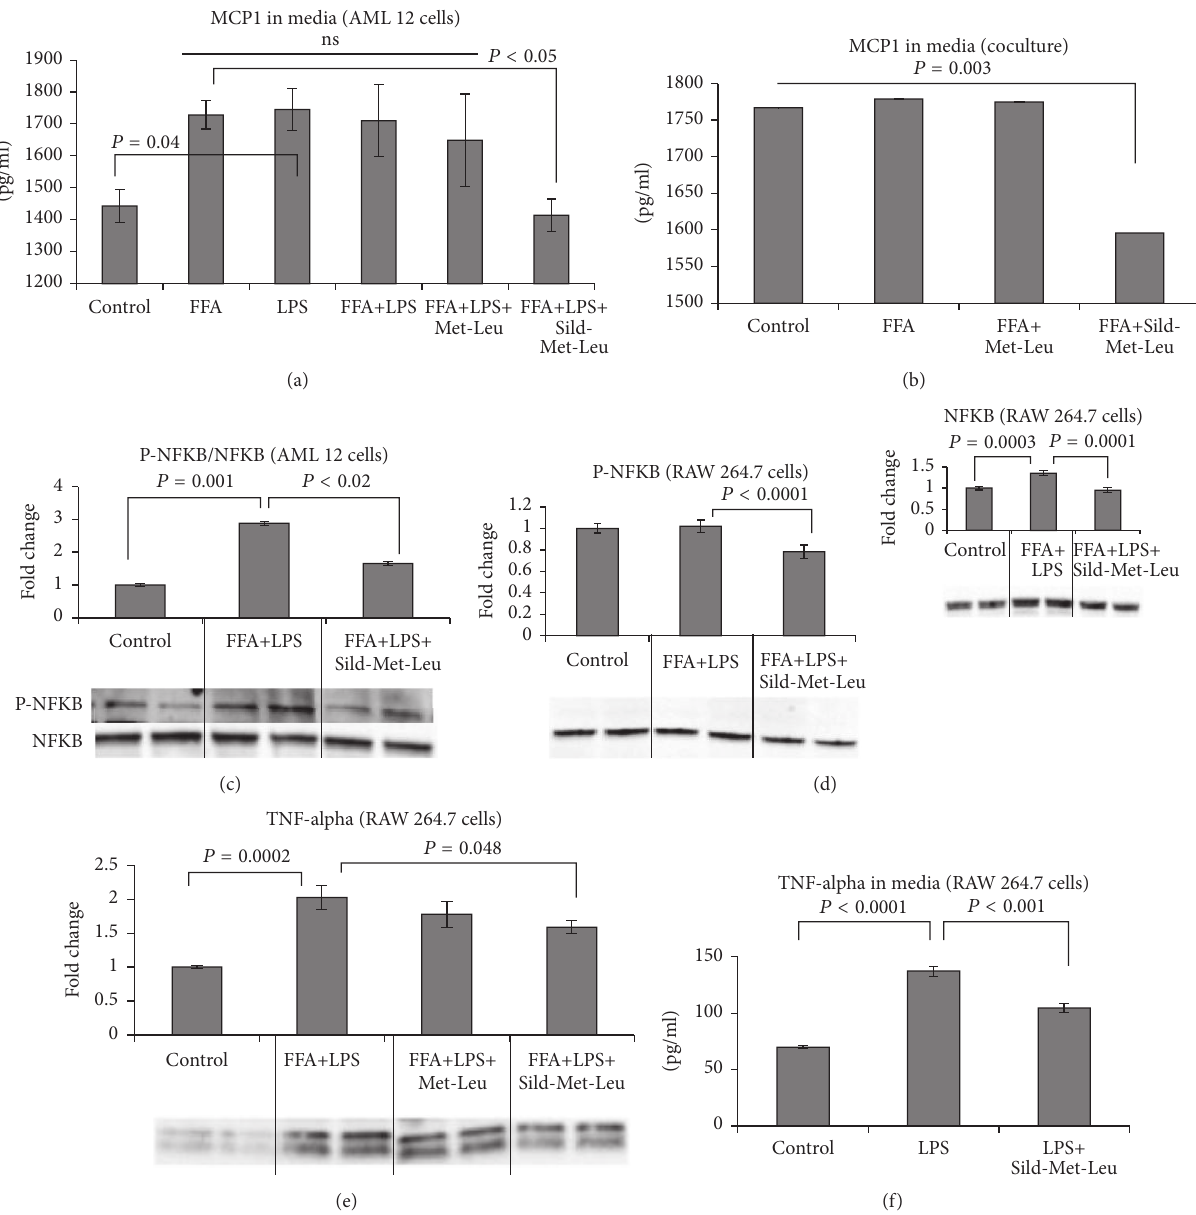
Figure 5: Sild-Met-Leu treatment decreases inflammatory marker in hepatocytes and macrophages. Mouse hepatocytes (AML cells) and macrophages (RAW 264.7 cells), grown individually or in coculture, were treated with sildenafil (1nM), metformin (0.1mM), and leucine (0.5 mM) as indicated for 24 hours after induction with free fatty acids (FFA) and/or LPS. Nontreated cells (control) were included for comparison. ((a)and(b))Monocytechemotacticprotein-(MCP-)1secretioninmediaofAMLcellsandofhepatocyte-macrophagecoculture. Data are presented as mean ± SEM ( 𝑛 = 4 to 10). ((c) to (e)) Protein expression of phosphorylated and total NF- 𝜅 B and TNF-alpha in AML 12 hepatocytes and RAW 264.7 macrophages. Quantitative data are presented as mean ± SEM ( 𝑛 = 4 ), and representative blots are shown. (f) Macrophage tumor necrosis factor- (TNF-) alpha secretion was measured in the media. Data are presented as mean ± SEM ( 𝑛 = 5